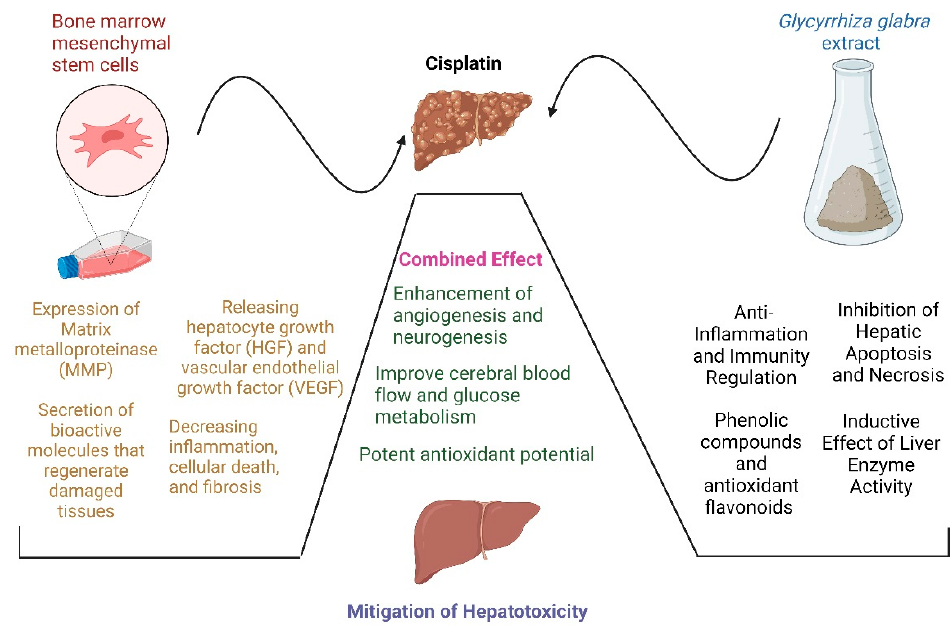
Figure 6. A summary of the suggested mechanism of Glycyrrhiza glabra and/or BM-MSCs on cisplatin-induced hepatocellular damage in rats.